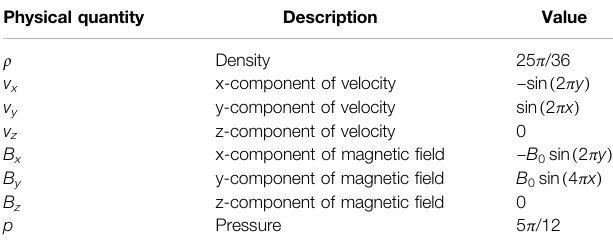
TABLE 1 | The initial conditions of